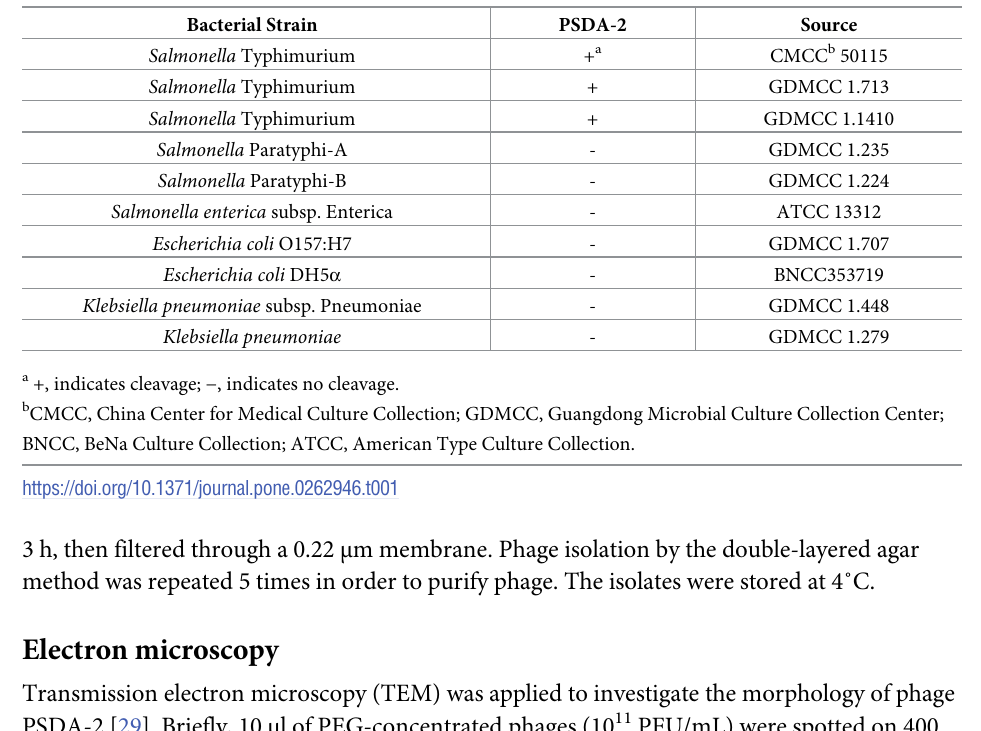
Table 1. Host range of the Salmonella phage PSDA-2. Bacterial Strain